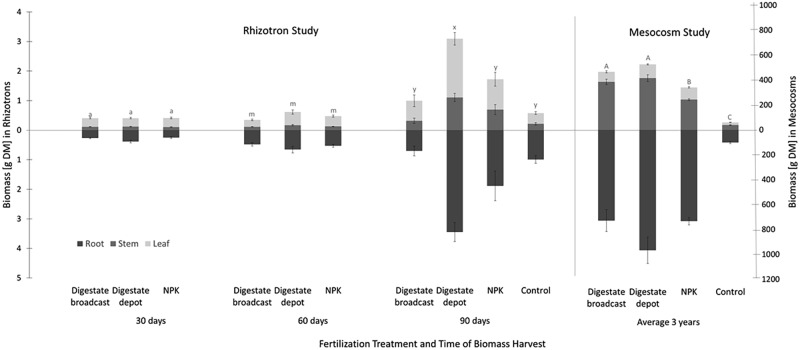
Plant biomass yield of S. hermaphrodita in rhizotrons and mesocosms. All fertilization treatments were adjusted to a digestate application of 40 t ha−1. Digestate broadcast: homogeneously incorporated in the top 20 cm; Digestate depot: localized digestate application; NPK: homogeneously incorporated in the top 20 cm; Control: no fertilization. Rhizotrons: n = 8 replicates for each treatment and time of harvest; Mesocosms: n = 7 replicates for each treatment harvested in 2014, 2015, and 2016. Root biomass was only measured in 2016. Values labeled with the same letter are not significantly different at p < 0.05; error bars indicate the standard error.